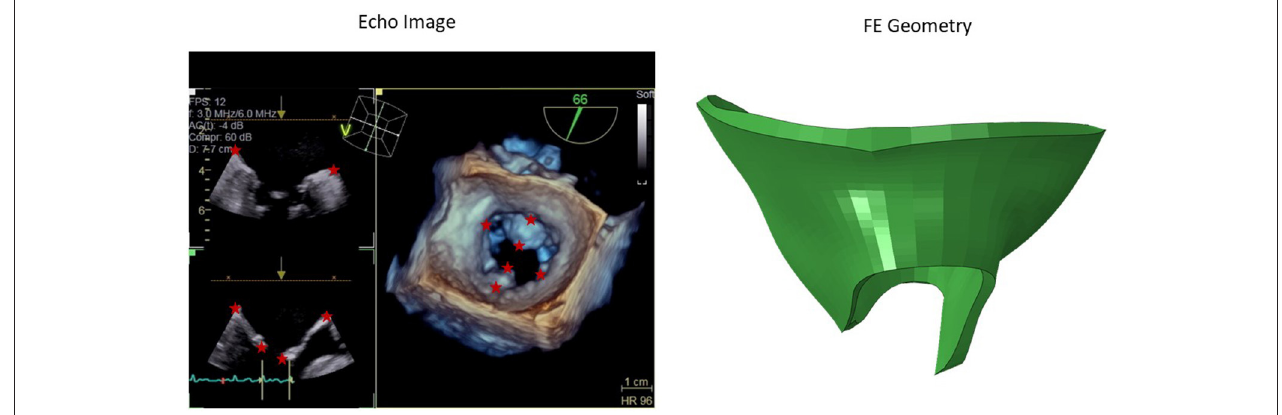
FIGURE 1 | A sample 3D echo image. Six key points used in the morphing are shown with stars. The pixel data from these key points were obtained manually in ImageJ, and they were used to create the respective geometry by morphing a template geometry. The shape on the right is the respective patient geometry after morphing.